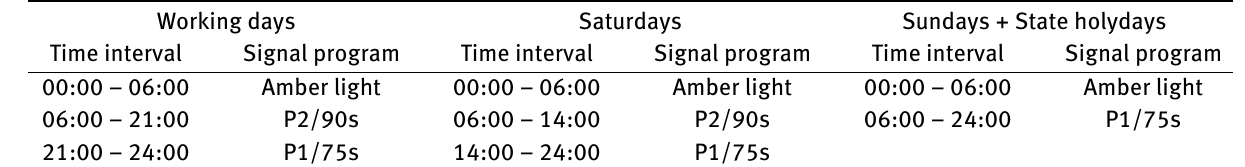
Table 1: Usage of signal programs